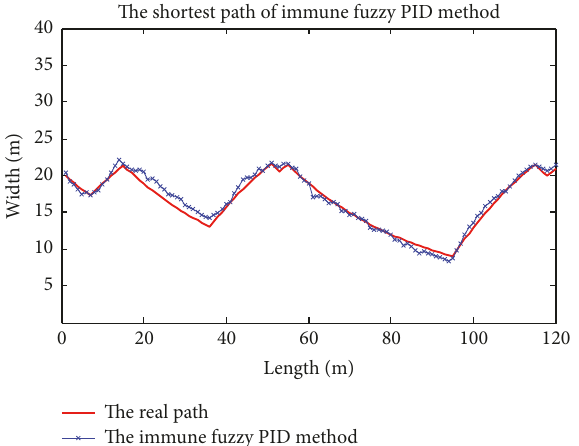
Figure 6: Time comparison